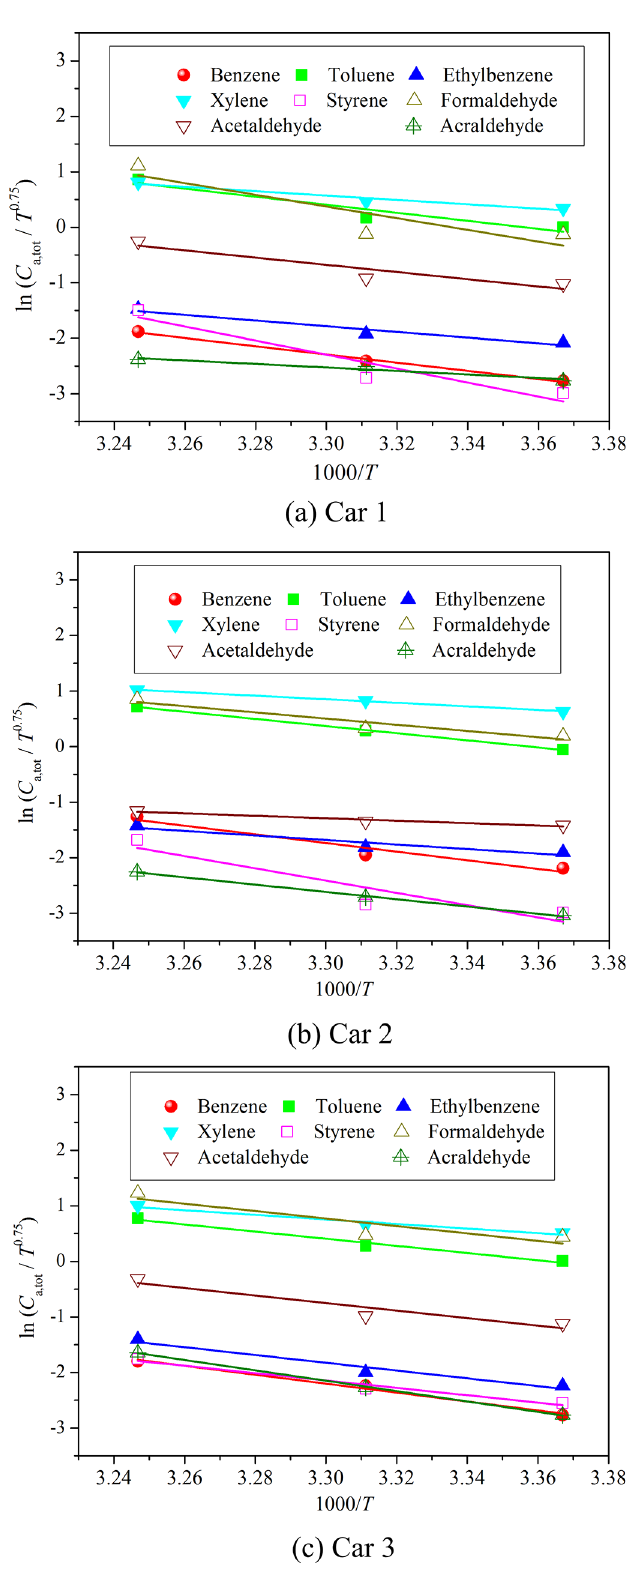
Fig 5. Validation of correlation (16) with experimental data from the three tested cars.